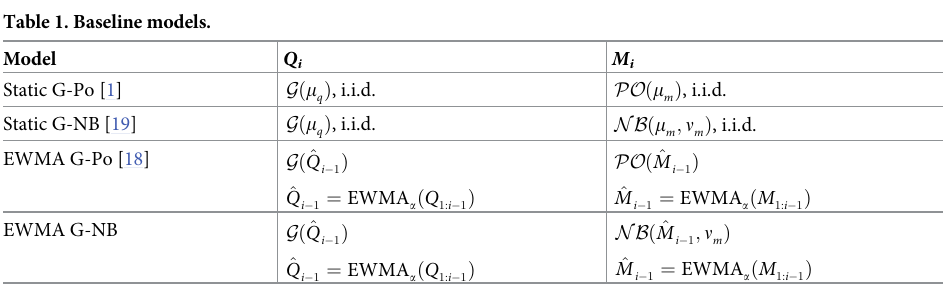
Table 1. Baseline